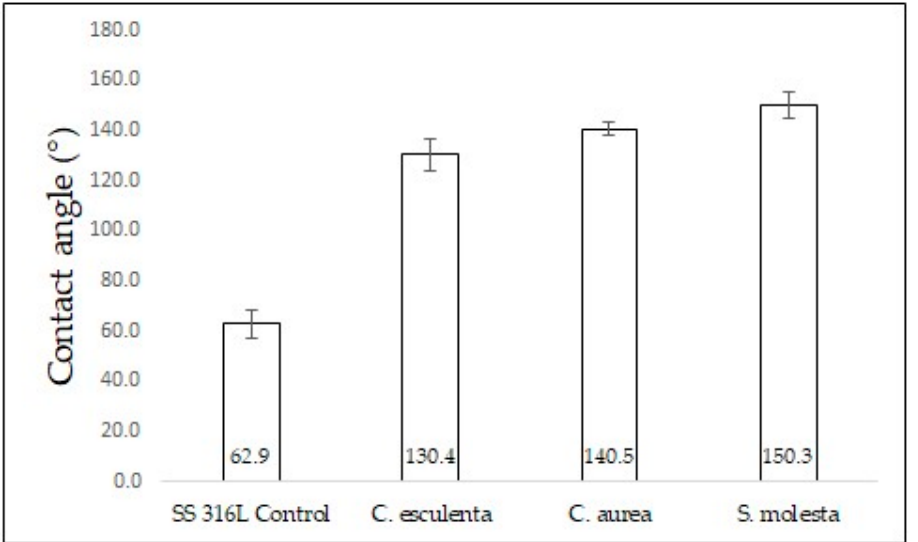
Figure 2. Contact angle measurements of control (SS 316L) surface and natural leaves.